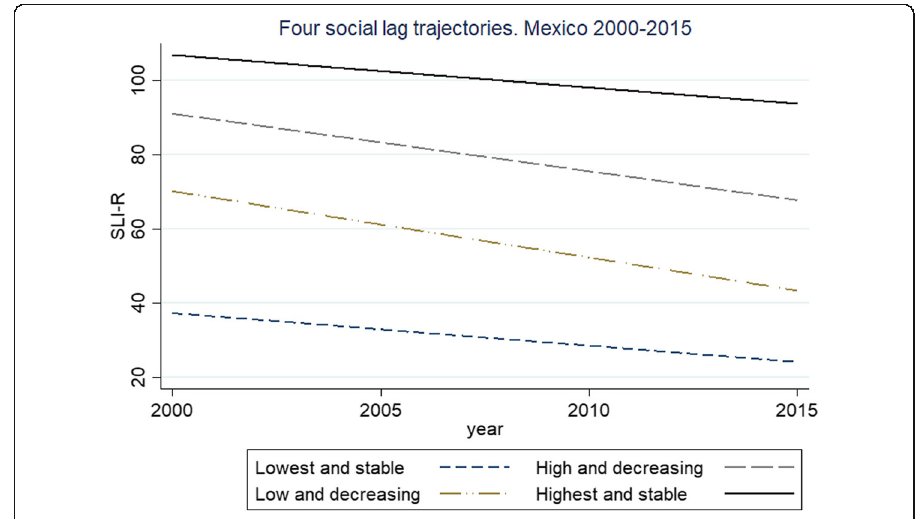
Fig. 4 Four class solution of social lag trajectories all